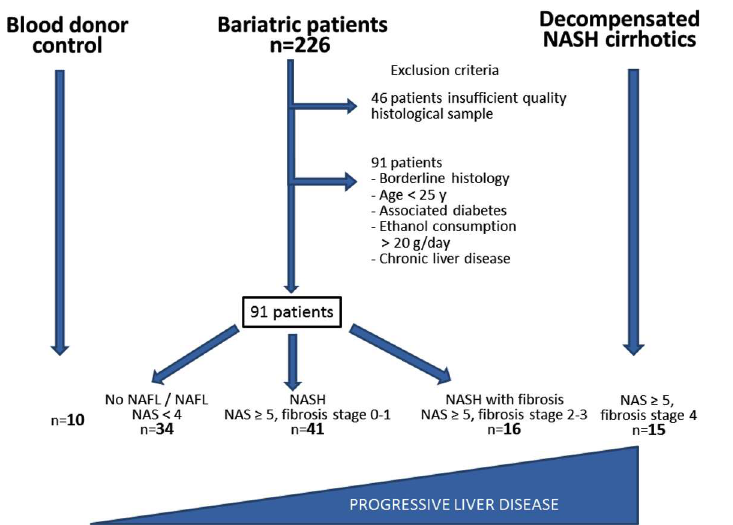
Fig 1. A schematic representation of the study